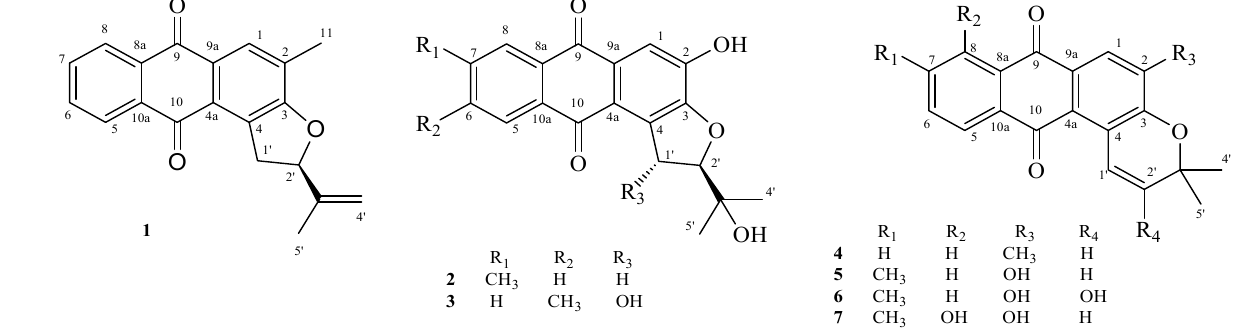
Figure 1. Structures of anthraquinones 1–7 isolated from H. diffusa. Compound 4 (Figure 1), collected as yellow powder, had a molecular formula C 20 H 17 O 3 deduced from HR-ESI-MS spectrum ( m/z 305.1170 [M+H] + , calcd. 305.1172, Figure S25). Some of its 1D (Figures S26 and S27) and 2D NMR data (Figures S28–S31) were similar to those of 1 , including an ABCD system ( δ 8.21 (2H, m, H − 5/H − 8), 7.76 (2H, m, H − 6/H − 7)) and a proton singlet at δ 8.07 (1H, s), suggesting the presence of 9,10-anthraquinone basic skeleton as that of 1 (Tables 1 and 2). The methyl ( δ 2.32, s, Me − 11) was located at C − 2 ( δ 132.5, s), determined by the HMBC correlation (Figure S31) between H − 1 ( δ 8.07, 1H, s) and C − 11 ( δ 16.5, q). In addition, the presence of two methyls ( δ 1.50 (6H, s, Me − 4 (cid:48) /5 (cid:48) )), and two cis -coupled olefinic protons ( δ 7.87 (1H, d, J = 10.4 Hz, H − 1 (cid:48) ) and 5.94 (1H, d, J = 10.4 Hz, H − 2 (cid:48) )) were observed. Meanwhile, two olefinic carbons ( δ 133.8 (d, C − 2 (cid:48) ),